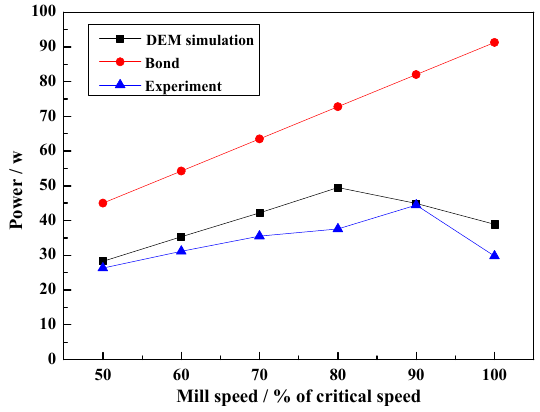
Figure 7. Power draws at different mill speeds.